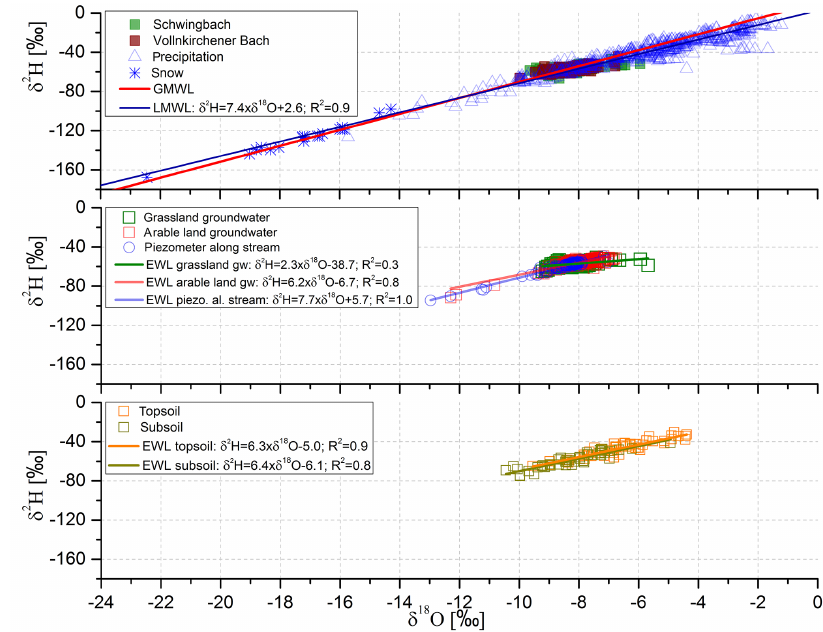
Figure 3. Local meteoric water line for the Schwingbach catchment (LMWL) in comparison to GMWL, including comparisons between precipitation, stream water, groundwater, and soil water isotopic signatures and the respective EWLs.